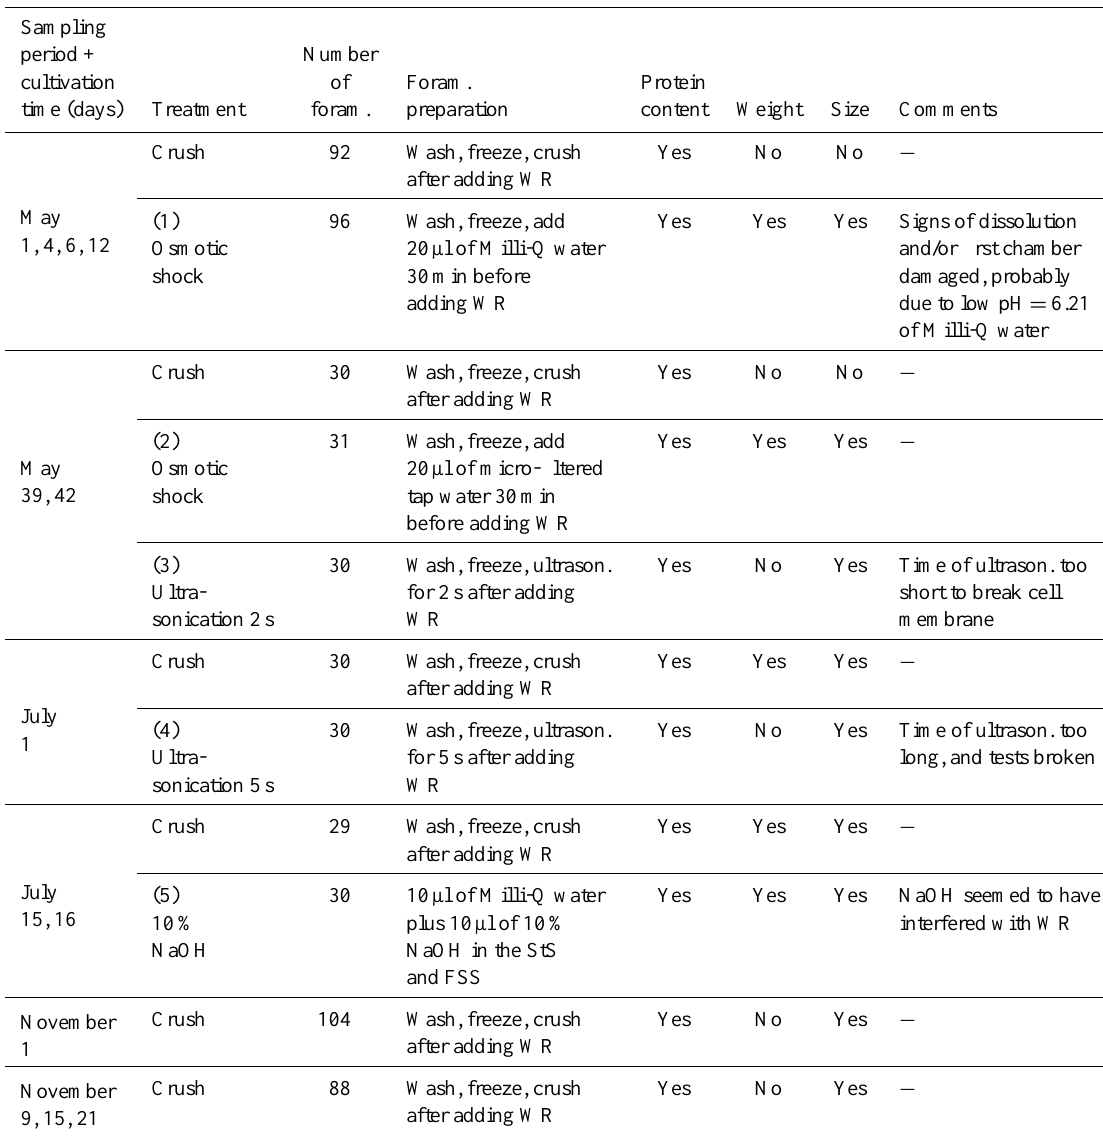
Table 4. Overview of the five processing methods for protein quantification plus control group of crushed tests. Specimens submitted to ultrasonication for 5s were severely damaged, and the original test weight could not be determined. All specimens that were not crushed were weighed and analysed for their